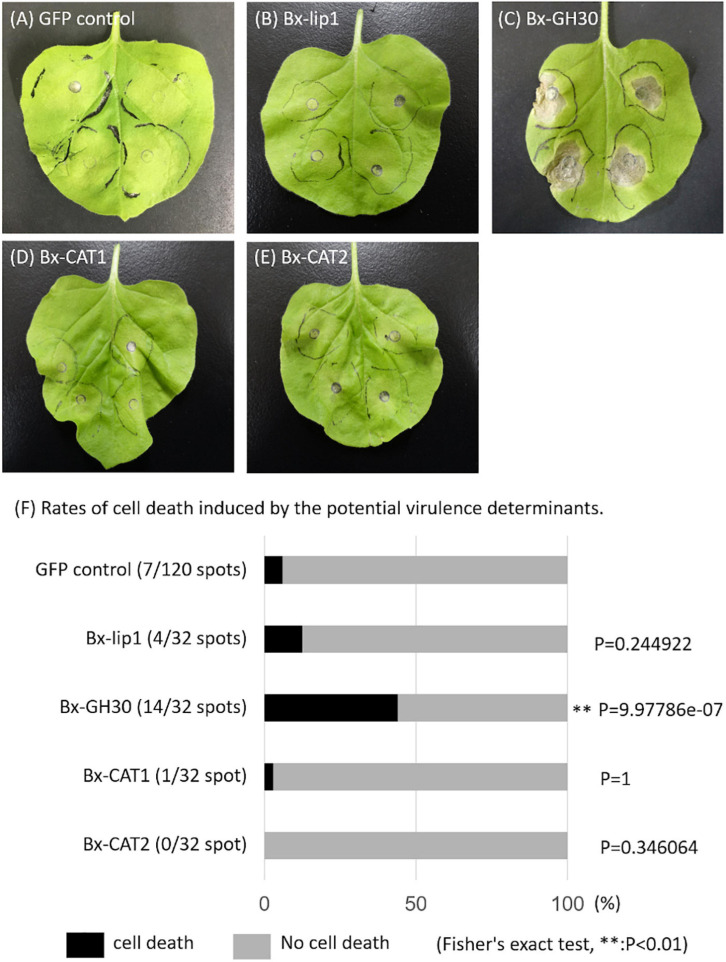
Symptoms and rates of cell death induced by potential virulence determinants. Leaves of Nicotiana benthamiana were infiltrated with Agrobacterium tumefaciens strains to express candidate B. xylophilus proteins. Images were captured at 10 days after infiltration: (A) the GFP-only vector control, (B) Bx-lip1, (C) Bx-GH30, (D) Bx-CAT1, and (E) Bx-CAT2. (F) The rates of cell death induced by candidate molecules are presented graphically. The degree of symptoms after infiltration was monitored visually and categorized into two classes: cell death (black bar) and no cell death (gray bar). The proportions of cell death in parentheses were statistically analyzed using Fisher’s exact test (∗∗P < 0.01). Asterisks indicate a significant increase in cell death induced by one of the four candidate pathogenic proteins, compared with the GFP-only vector control.